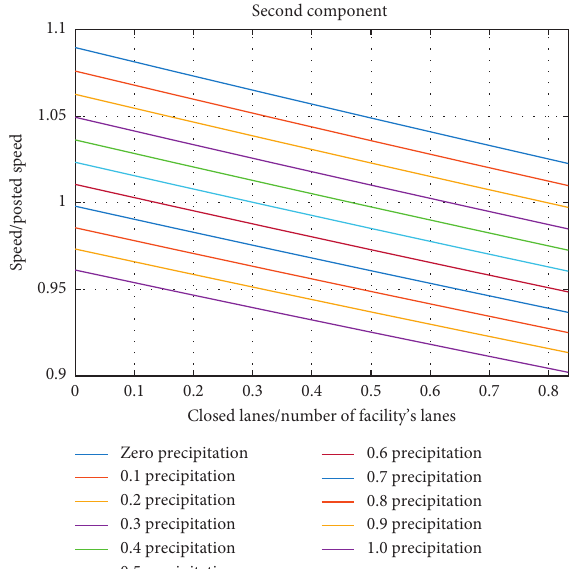
Figure 8: The change of the mean of the second component (free-flow regime) with the precipitation and ratio of closed lanes.